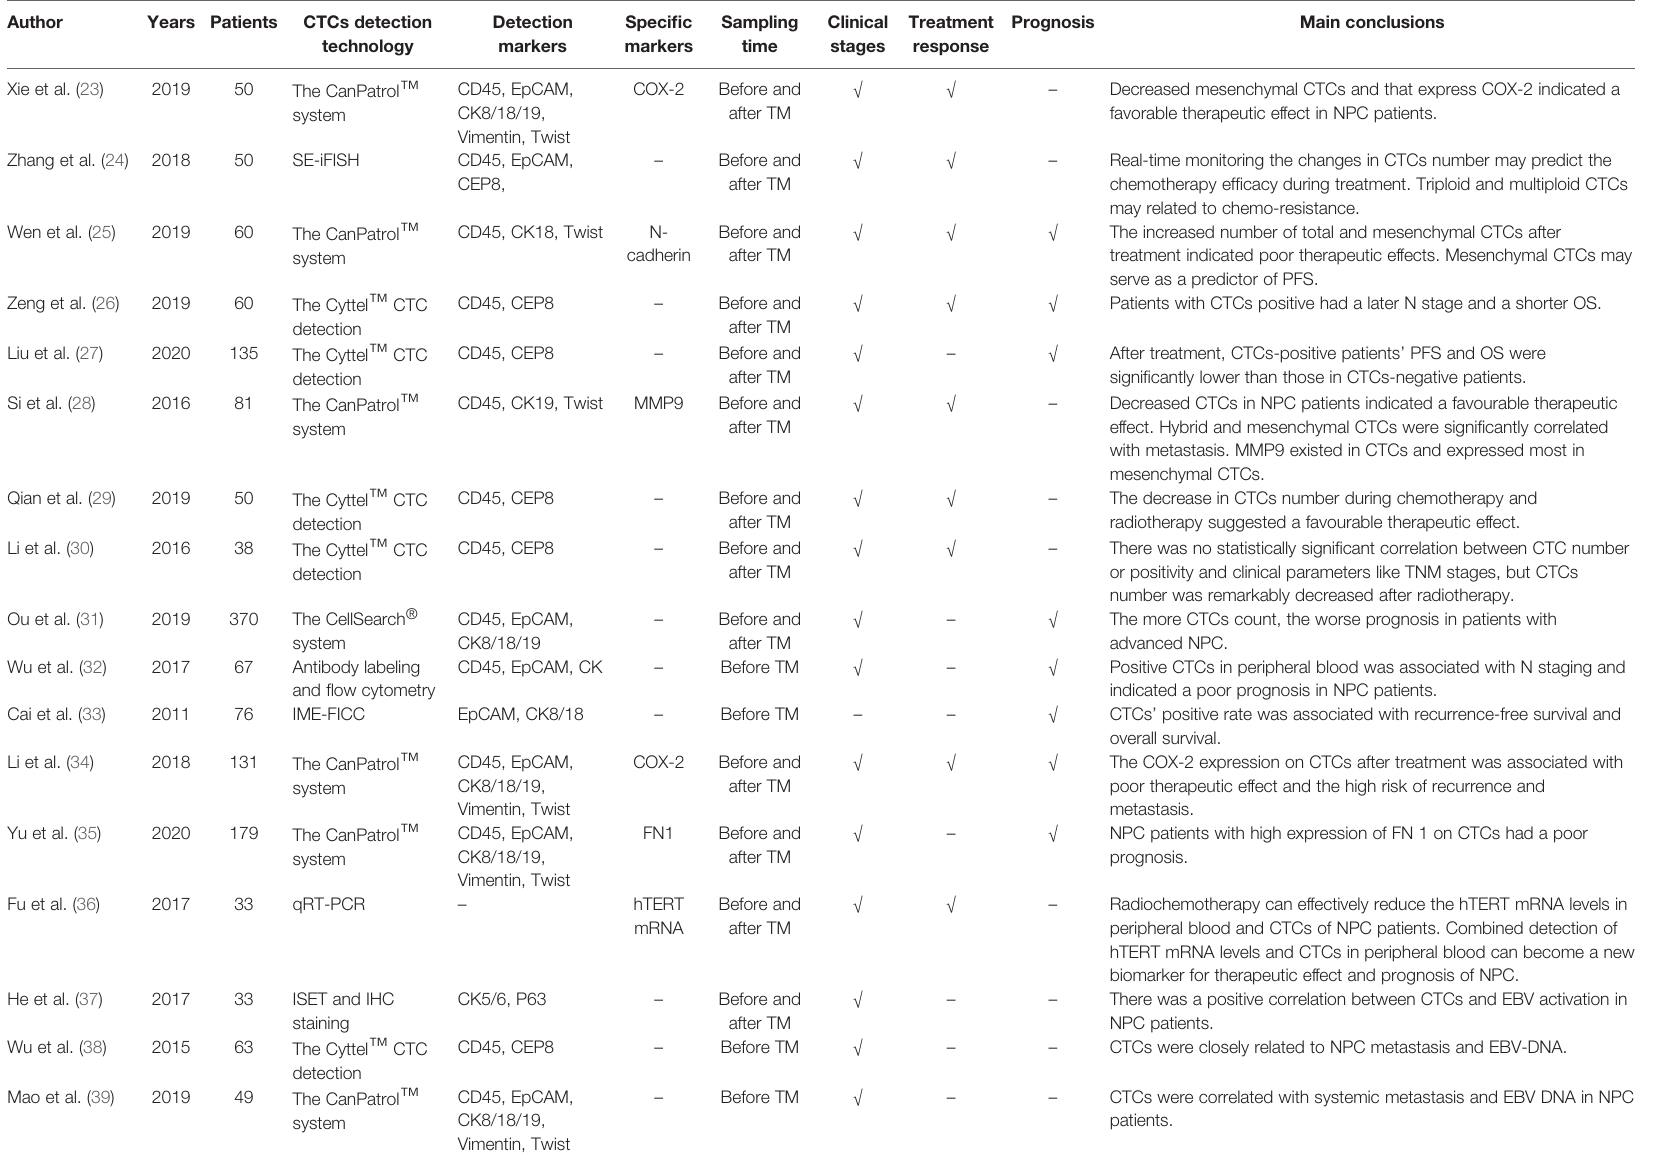
TABLE 1 | Summary of studies on CTCs in nasopharyngeal